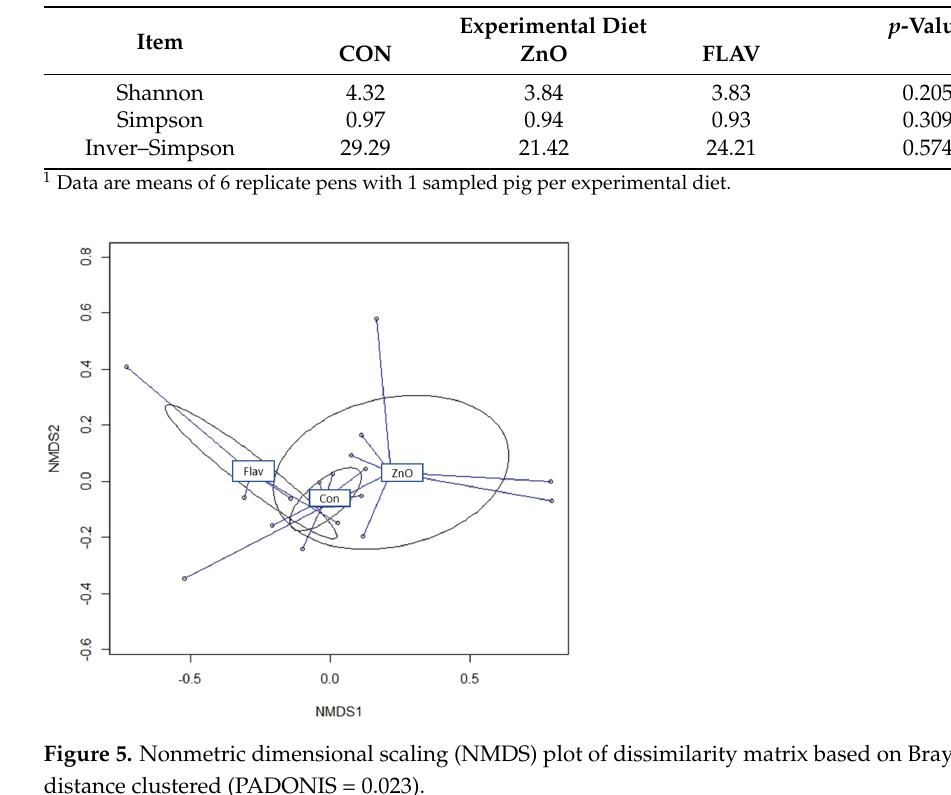
Figure 5. Nonmetric dimensional scaling (NMDS) plot of dissimilarity matrix based on Bray–Curtis distance clustered (PADONIS = 0.023).